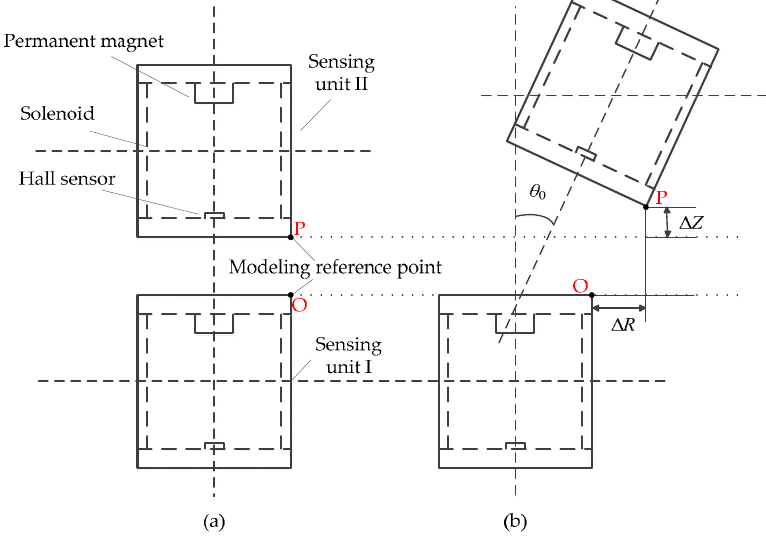
Figure 3. Schematic diagram of the optimized measurement unit. ( a ) Initial geometrical setting; ( b ) occurrence of relative horizontal displacement Δ R , vertical displacement Δ Z and tilt angle θ 0 .